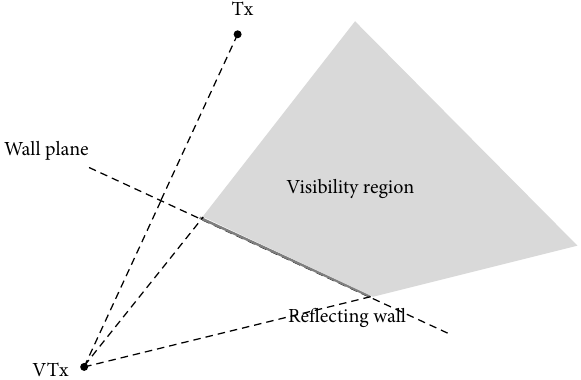
Figure 1: Example of VTx and visibility region for a reflecting